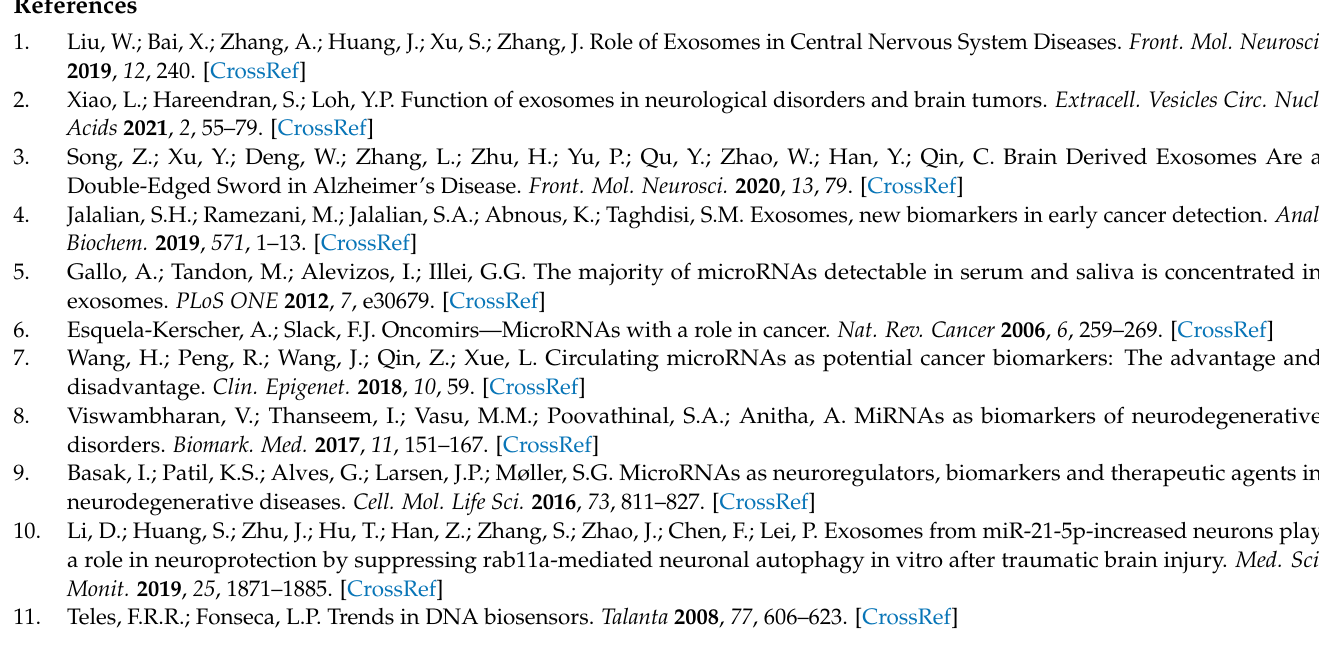
Figure S3: (A)—EIS changes corresponding to the different miRNA 21-5p concentrations; (B)—Charge transfer resistance of each concentration (100s AuNPs electrodeposition), Figure S4: (A)—EIS changes corresponding to the different miRNA 21-5p concentrations; (B)—Charge transfer resistance of each concentration (300s AuNPs electrodeposition), Figure S5: (A)—EIS changes corresponding to the different miRNA 21-5p concentrations; (B)—Charge transfer resis- tance of each concentration (600s AuNPs electrodeposition), Figure S6: (A)—EIS changes corre- sponding to the different miRNA 21-5p concentrations; (B)—Charge transfer resistance of each concentration (1200s AuNPs electrodeposition), Figure S7: AFM scans of AuNPs electrodeposi- tion in 3D (left) and 2D (right) views of the different stages. (A)—900s AuNPs electrodeposition (B)—900s AuNPs electrodeposition/anti-miRNA 21-5p (C)—900s AuNPs electrodeposition/anti- miRNA 21-5p/miRNA